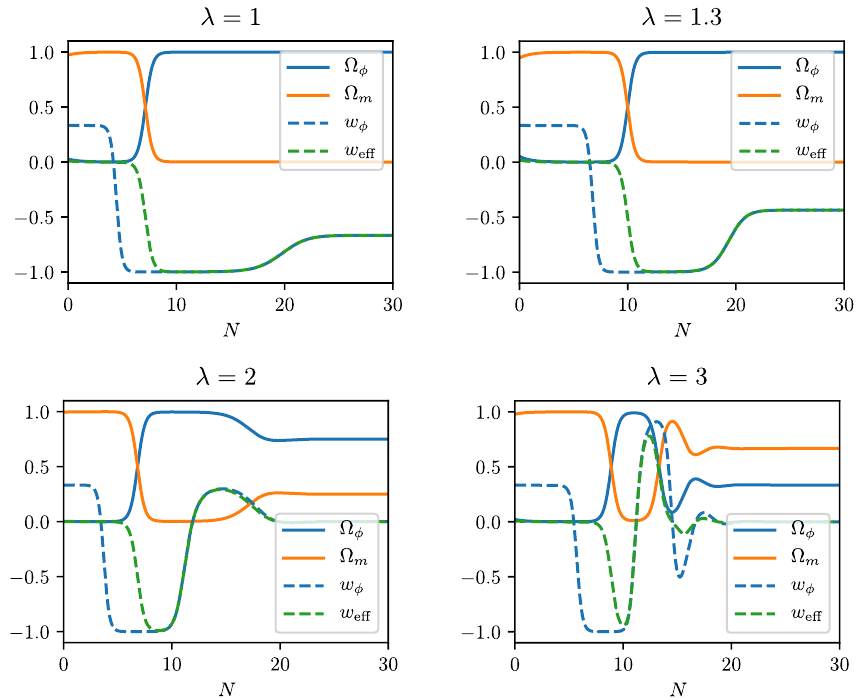
Figure 2 . Evolution of the scalar field parameters (3.7) following from the system (3.4)–(3.6), for w = 0 and different values of λ . We denoted Ω m = 1 − Ω φ and w eff = w Ω m + x φ Ω φ . We choose initial ν i = 10 10 to have between 8 and 10 e-folds of matter domination and x i , y i to have Ω φ < 0 . 2